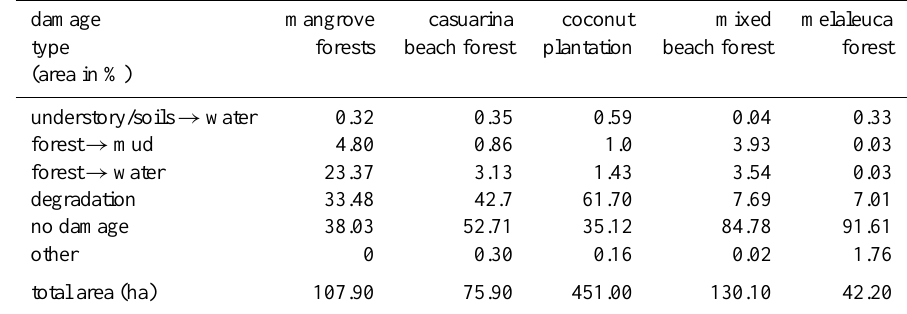
Table 6. Damage statistics based on CVA. Table 5. Damage statistics (area in %) based on DMC.